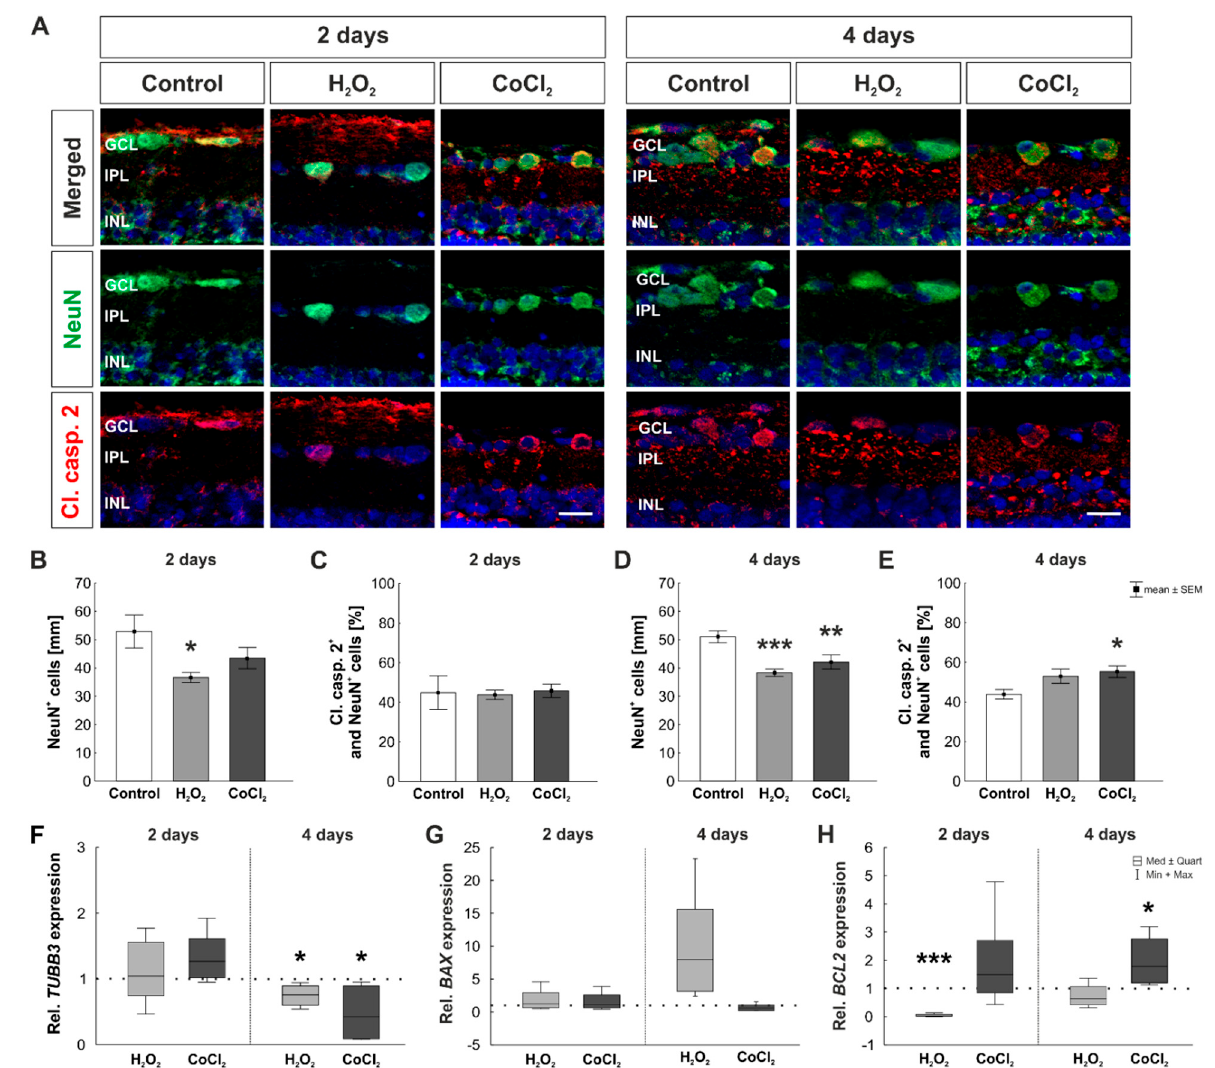
Figure 4. Loss of retinal neurons due to oxidative stress and hypoxia. ( A ) Retinal neurons were stained with a NeuN antibody (green) and co-stained with the apoptotic marker cleaved caspase 2 (red). Cell nuclei were labelled with DAPI (blue). ( B ) A significant loss of NeuN + cells was noted in the H 2 O 2 group ( p = 0.04), but not in the CoCl 2 group after two days. ( C ) At day two, the number of apoptotic NeuN + cells was comparable in all three groups. ( D ) At four days, both stressors, H 2 O 2 and CoCl 2 , led to a significant loss of NeuN + cells ( p < 0.001 and p = 0.011). ( E ) NeuN + cells loss was accompanied by an increased number of apoptotic cells after CoCl 2 -stress ( p = 0.035). ( F ) Significant downregulation of TUBB3 mRNA was noted in both stressor groups after four days (both: p = 0.02). ( G ) mRNA expression levels of BAX was not altered between groups at both investigated points in time. ( H ) H 2 O 2 led to a significant downregulation of BCL2 mRNA expression at two days ( p = 0.002), BCL2 levels were significantly upregulated in CoCl 2 samples at four days ( p = 0.03). GCL = ganglion cell layer; IPL = inner plexiform layer; INL = inner nuclear layer. ( B , C ): n = 5; D, ( E ): n = 8; ( F – H ): n = 4–5. Scale bars: 20 µm. Values are shown as mean ± SEM for immunofluorescence and median ± quartile + min/max for RT-qPCR. The dotted lines in ( F – H ) represent the relative expression of the control group. Columns marked with * show significant differences in comparison to the control group. * p < 0.05; ** p < 0.01; *** p < 0.001.